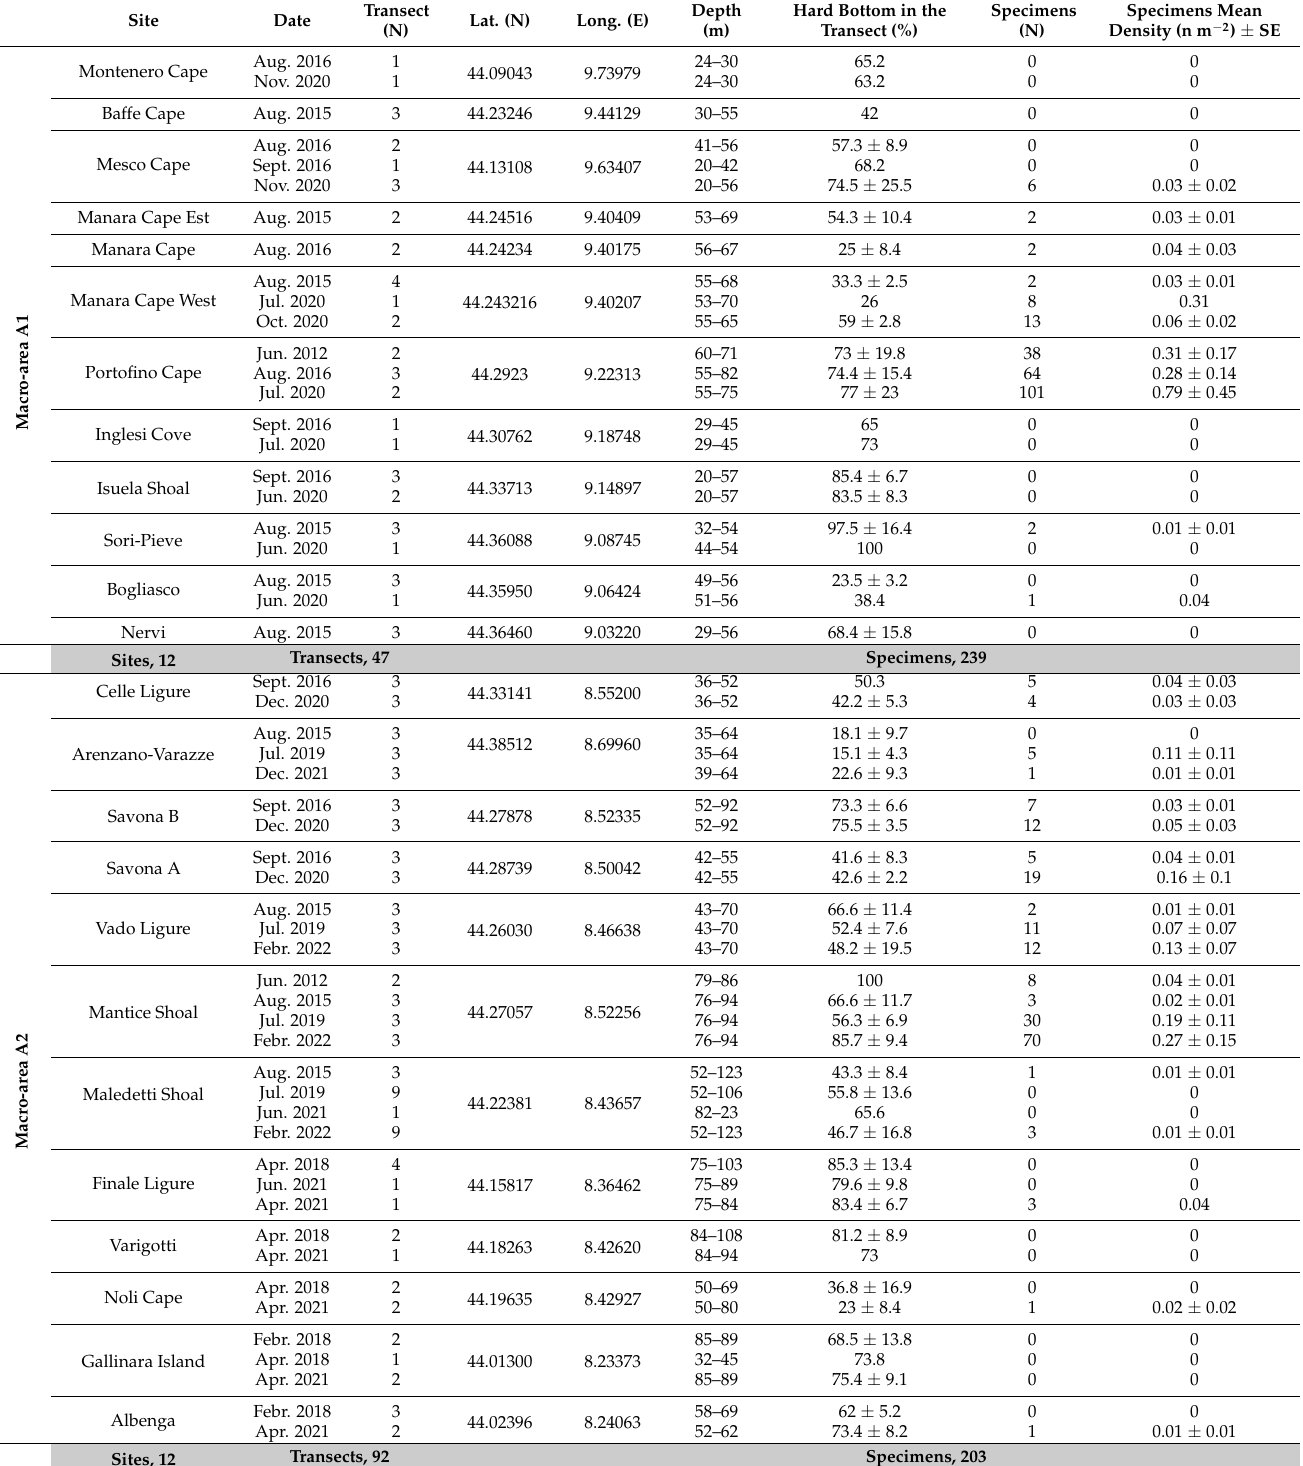
Table 1. Explored sites and recorded Astrospartus mediterraneus in the three macro-areas of the Ligurian